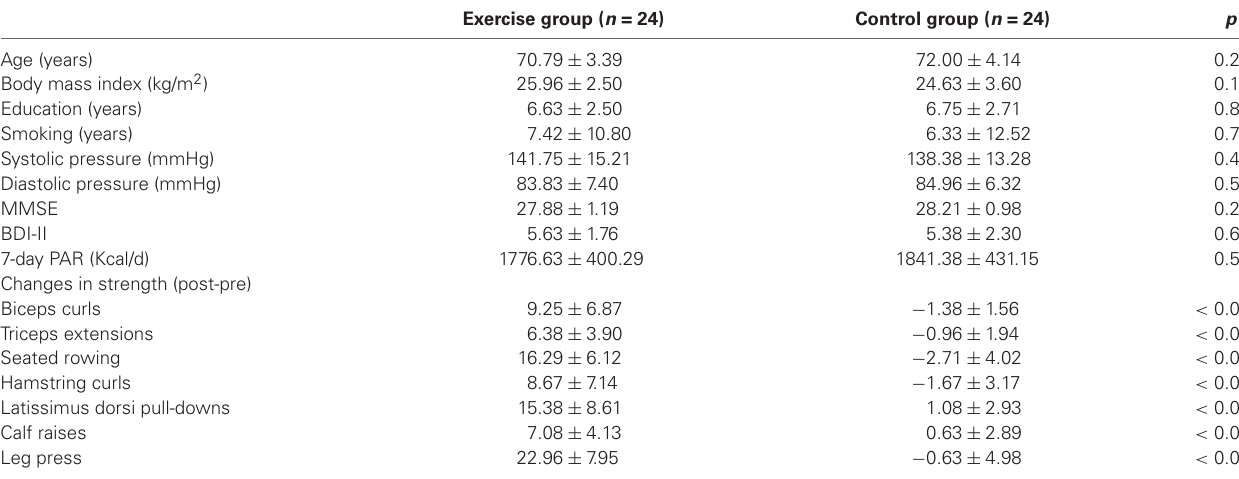
Table 1 | Demographic characteristics of the exercise and control groups